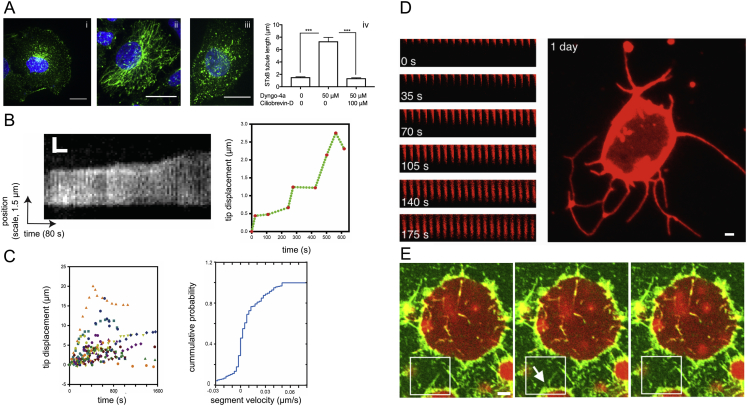
Molecular Motors Work with EndoA2 to Induce FDS, Related to Figure 5(A) Effect of dynein motor on STxB tubules. Incubation of HeLa cells for 1 hr at 37°C with (i) untreated (control), (ii) 50 μM dyngo-4a (dynamin inhibitor), and (iii) 50 μM dyngo-4a +100 μM ciliobrevin-D (dynein inhibitor), followed by incubation with STxB-A488 (5 μg.mL−1) for 10 min. Determination of tube length on fixed cells; ∗∗∗p < 0.001 (One-way Anova test). Blue: Hoechst dye; green: STxB-A488. Data are mean ± SEM of two independent experiments (n = 25 cells per condition). (B) Left: kymogram of a CTxB-containing tube elongated by dynein in an ATP depleted COS-7 cell. The position of the line used to generate the kymogram is highlighted in orange in Figure 5A in the main text. Cholera toxin B-subunit is fluorescently labeled. Right: the corresponding trajectory of the tubule tip as a function of time as traced from the kymogram. (C) Left: traces of tip displacement over time for 25 different tubules. Each individual tubule is indicated by a different symbol. Right: the cumulative probability plot of the resulting 228 measurements of segment velocity calculated as the slope of the lines between individual data points. Note, the corresponding histogram is in Figure 5A in the main text. (D) Left: kymogram of a tubule extruded from a GUV by kinesin motors (split into six lines, with each line indicating the time of the first image), showing the growth of the tubule shown in Figure 5C in the main text. The total vertical length in each segment is 3.55 μm. Right: another example with many extruded tubules, taken one day following the experiment. The chamber was sealed with putty sealant and kept in the fridge overnight. Lipids are fluorescent. Scale bar, 2 μm. (E) Time-lapse microscopy of FDS of endoA2-covered tubules pulled by kinesin motors. The arrow points to a scission location just prior to breakage. Overlaid fluorescence of lipids (red) and endoA2 (green). Scale bar, 2 μm.